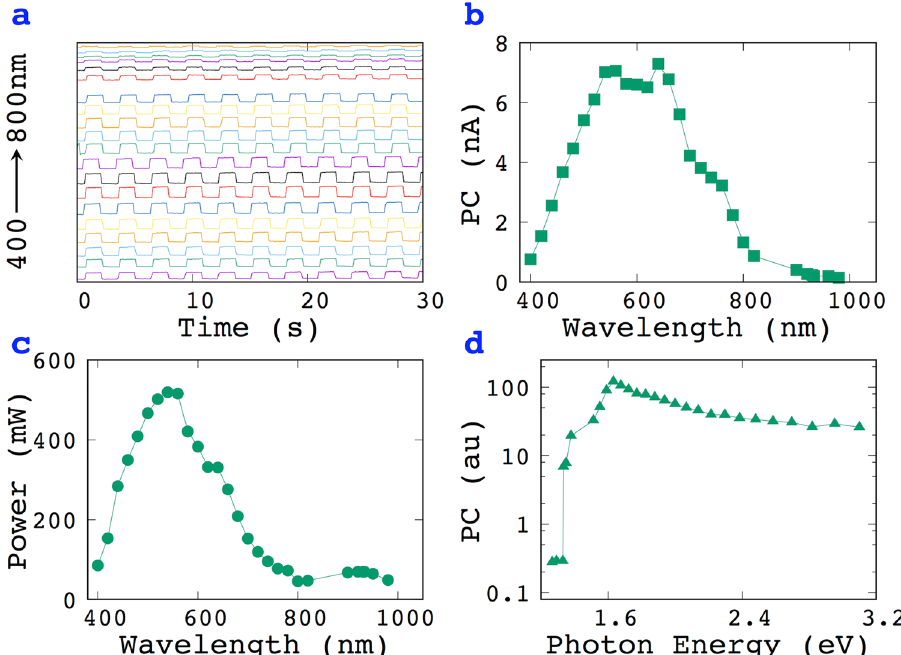
Figure 4. Photoresponse of a MoS 2 film at various wavelengths where the light with different wavelengths was separated by a monochromator. ( a ) Time-resolved photoresponse of a MoS 2 film, ( b ) Plot of PC versus wavelength, ( c ) The power of light from the monochromator, ( d ) Plotted PC (au) versus photon energy.